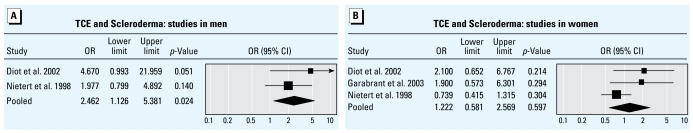
Association between risk of scleroderma and occupational exposure to TCE in men (A) and women (B), based on data from three case–control studies (Diot et al. 2002; Garabrant et al. 2003; Nietert et al. 1998). The graphics show the estimated measures of association from these studies. The pooled estimates are based on a meta-analysis using a random-effects model to include the possibility of nonrandom error between studies. Each square and corresponding line represent the OR and 95% CI from the individual study, with the relative size of the squares reflecting the relative weights of the studies. The horizontal midpoint of each diamond represents the pooled OR estimate and the horizontal extremes indicate the 95% CI.